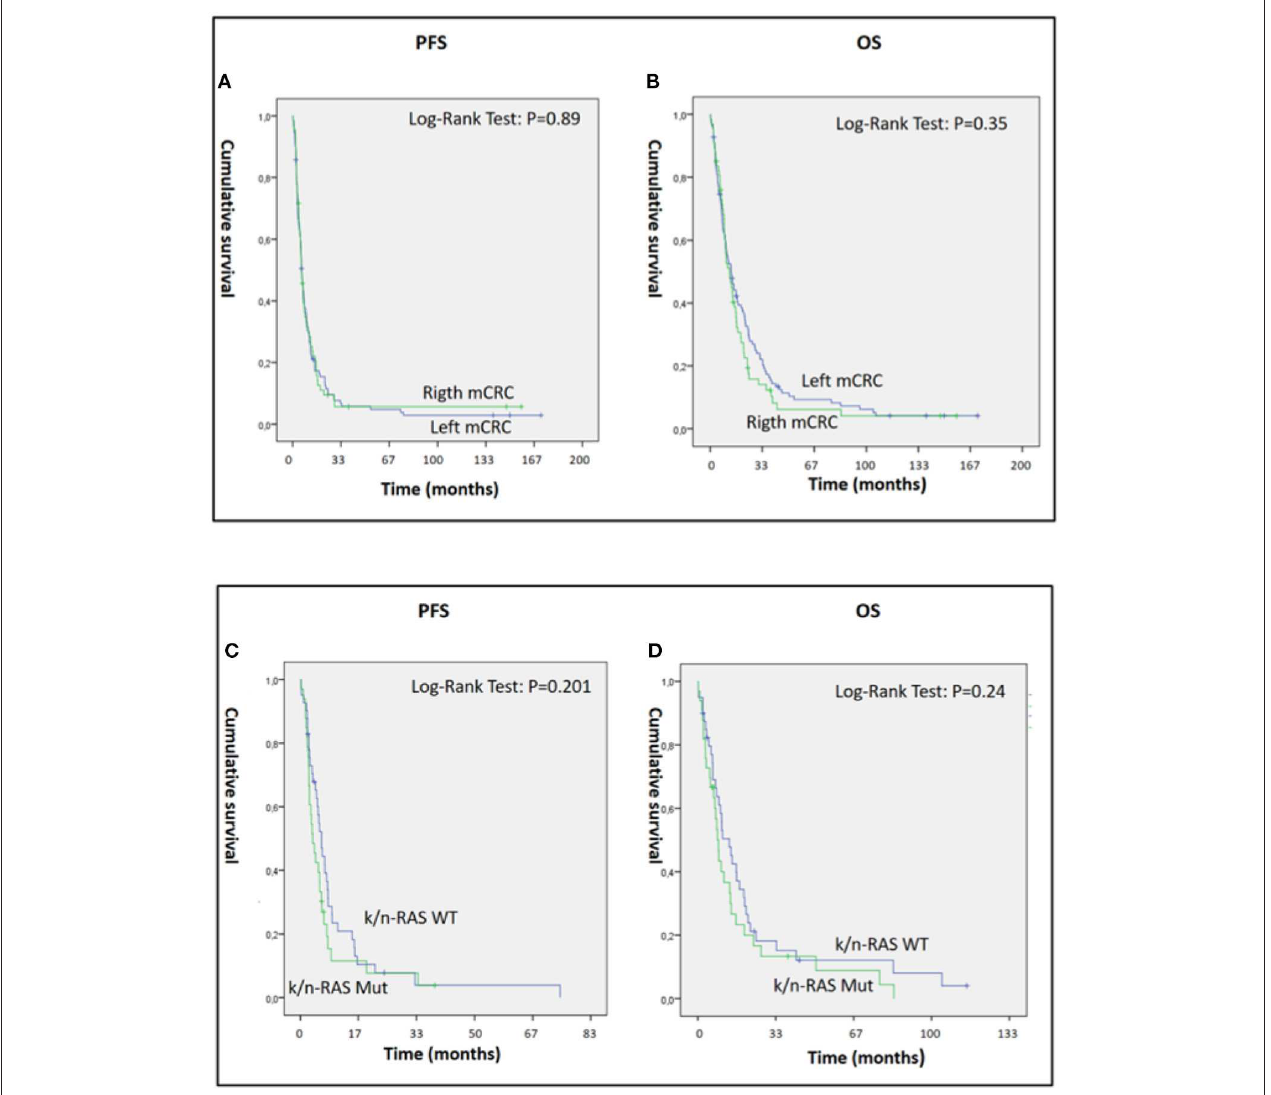
FIGURE 2 | (A–D) Panels A and B represent PSF (A) and OS (B) of 179 mCRC patients who received GOLFIG chemo-immunotherapy with left (112 pts) and right primary sidedness (67 pts). (C,D) represent PFS (C) and OS (D) of 74 mCRC patients who received GOLFIG chemo-immunotherapy with wt (41 pts) and mutated K/N-ras (33 pts). Both primary tumor sidedness and K/N-ras mutational status did not influence the outcome of these